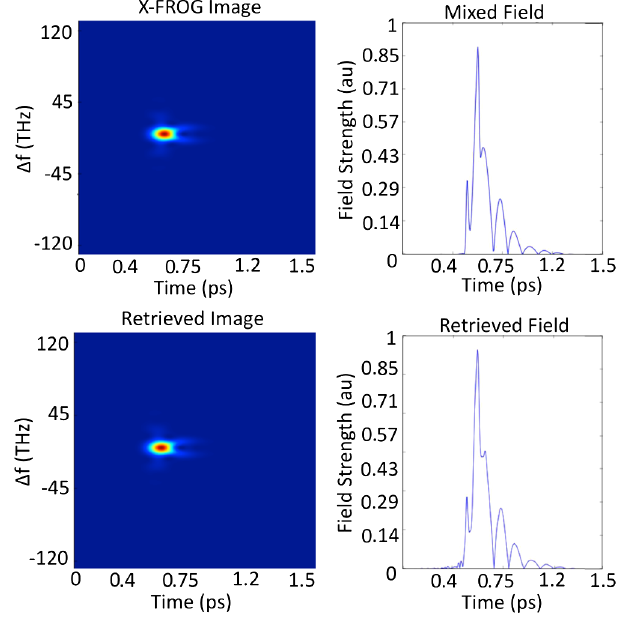
FIG. 9. Comparison between X-FROG (top) and results from phase retrieval algorithm (bottom) for 15 fs electron beam in 50 (cid:10) m of ZnTe. Error was 8 (cid:5) 10 (cid:1) 9 for this example.